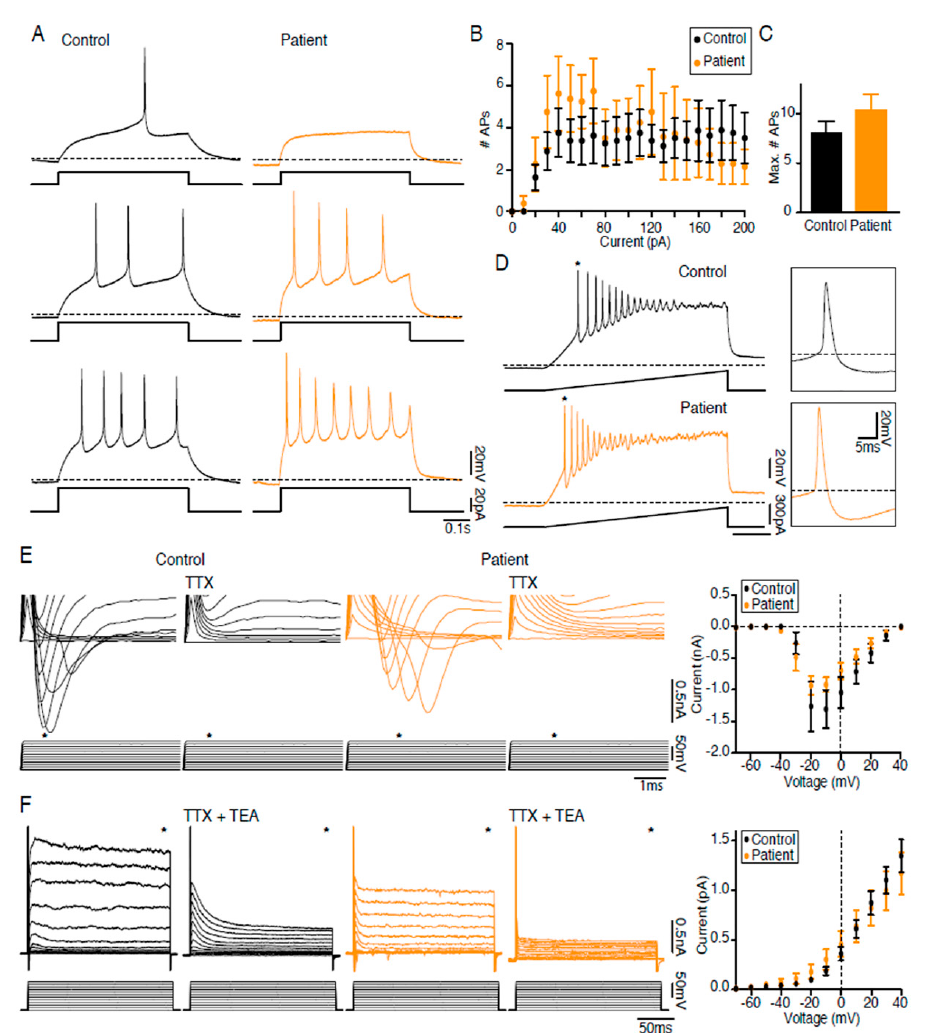
Figure 5. LS iPSC-derived neurons are electrophysiologically functional. ( A ) Neurons derived from control (black) and patient (orange) neural stem cells were able to generate action potentials (APs) upon current injection. ( B ) Graph showing the injected current versus the number of APs elicited ( n = 8). ( C ) Bar diagram of the maximal number of APs induced ( n = 8, n.s.). ( D ) Voltage traces show that current injection (ramp from 0–300 pA) induces trains of APs; * denotes the expanded AP17. ( E , F ) Left: Current traces of the fast inward current peak ( E ) and the sustained outward current ( F ) activated by step depolarizations from a holding potential of − 70 mV in the absence and presence of 1 mM TTX ( E ) or 1 mM TTX and 10 mM TEA ( F ); * denotes the fast inward current peak ( E ) and the sustained outward current ( F ). Right: Voltage–current plot of the inward current peak ( E ) and sustained outward current ( F ).